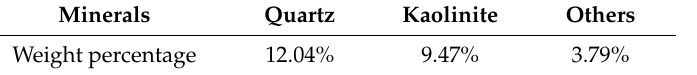
Table 2. Results of quantitative analysis of 8 1 coal sample minerals.